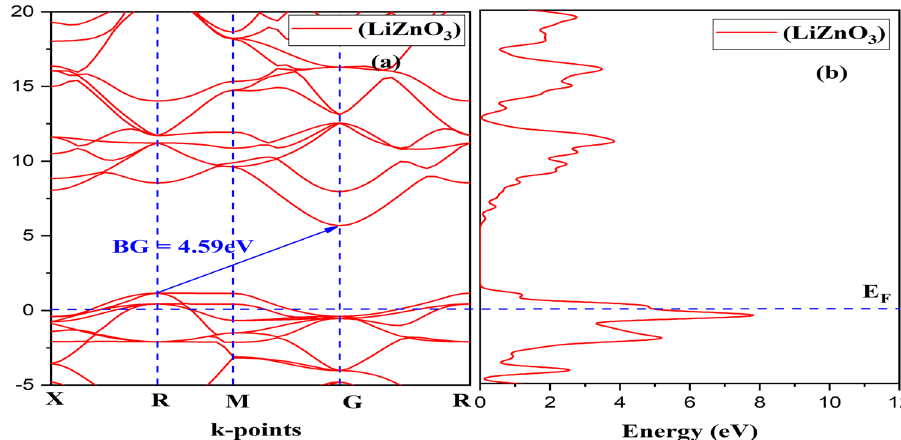
Fig. 2 Compound LiZnO